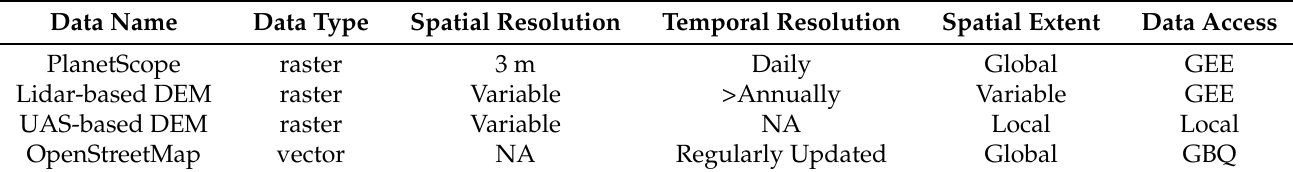
Table 1. Rapid-DEM uses four data sources in order to detect, plan, fuse, and update DEM in areas experiencing topographic